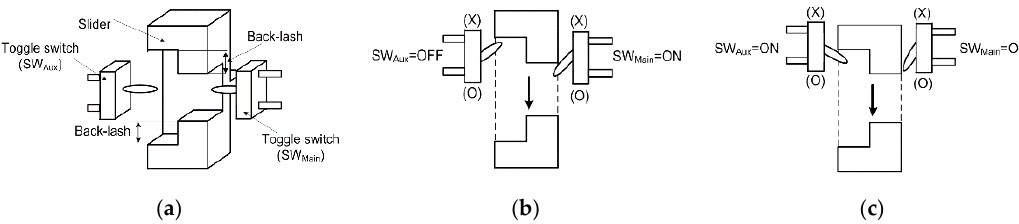
Figure 6. Mechanical interlock concept between main switch (SW Main ) and auxiliary switch (SW Aux ) using slider and toggle switch; ( a ) interlock structure; ( b ) State 1 (SW Main ) = ON/(SW Aux ) = OFF; ( c ) State 2 (SW Main ) = ON/(SW Aux ) = ON.